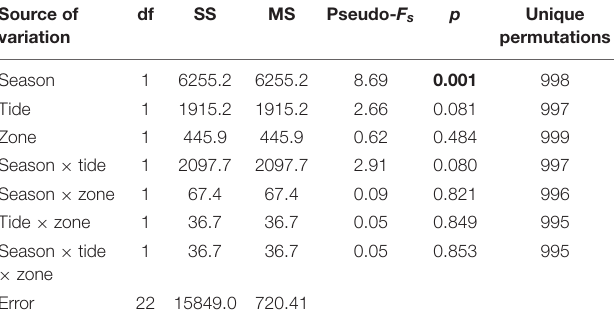
TABLE 2 | PERMANOVA of the total fish catches per day (abundance) according to season, tide, and zone, based on non-transformed